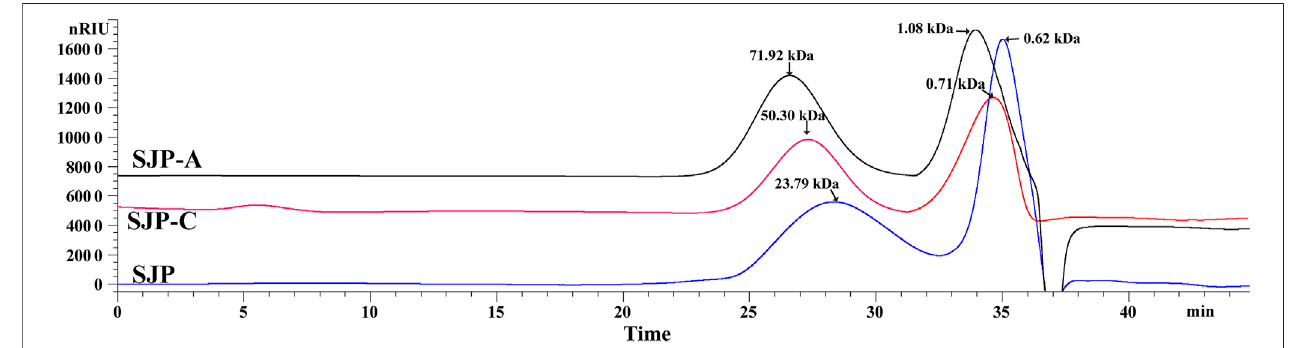
FIGURE 1 | HPSEC pro fi les of SJP, SJP-A, and SJP-C. HPSEC, high-performance size exclusion chromatography; SJP, seaweed Laminaria japonica